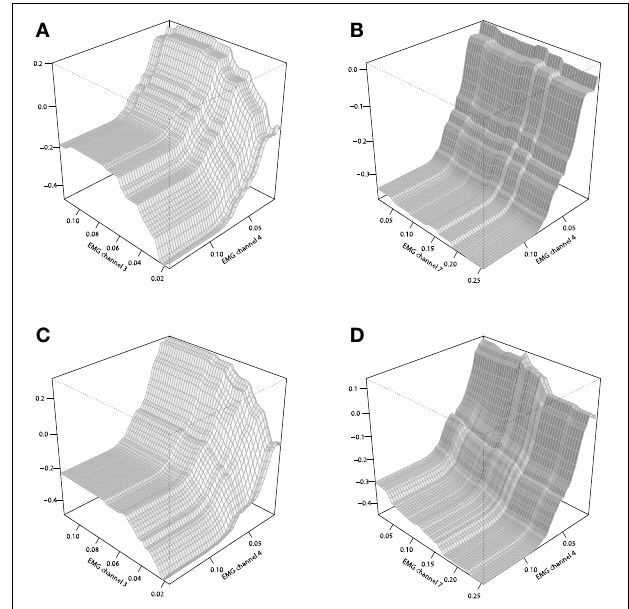
FIGURE 11 | Interaction plots of the tree-based GBMs on the EMG robotic control data. (A) stump-based GBM, channels 3 and 4; (B) stump-based GBM, channels 4 and 7; (C) tree-based GBM ( d = 4), channels 3 and 4; (D) tree-based GBM ( d = 4), channels 4 and 7.